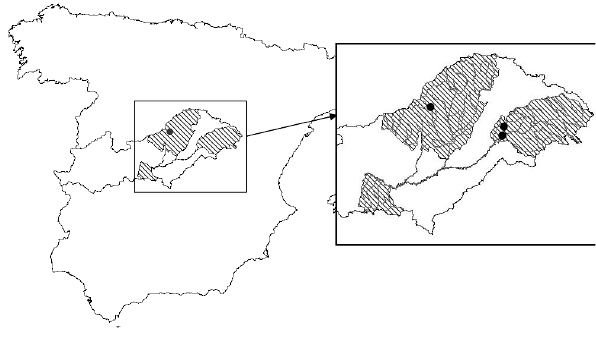
Fig. 1. Location of the three case studies. The lined area corre- sponds to the 32nd homogeneous region in the Tagus